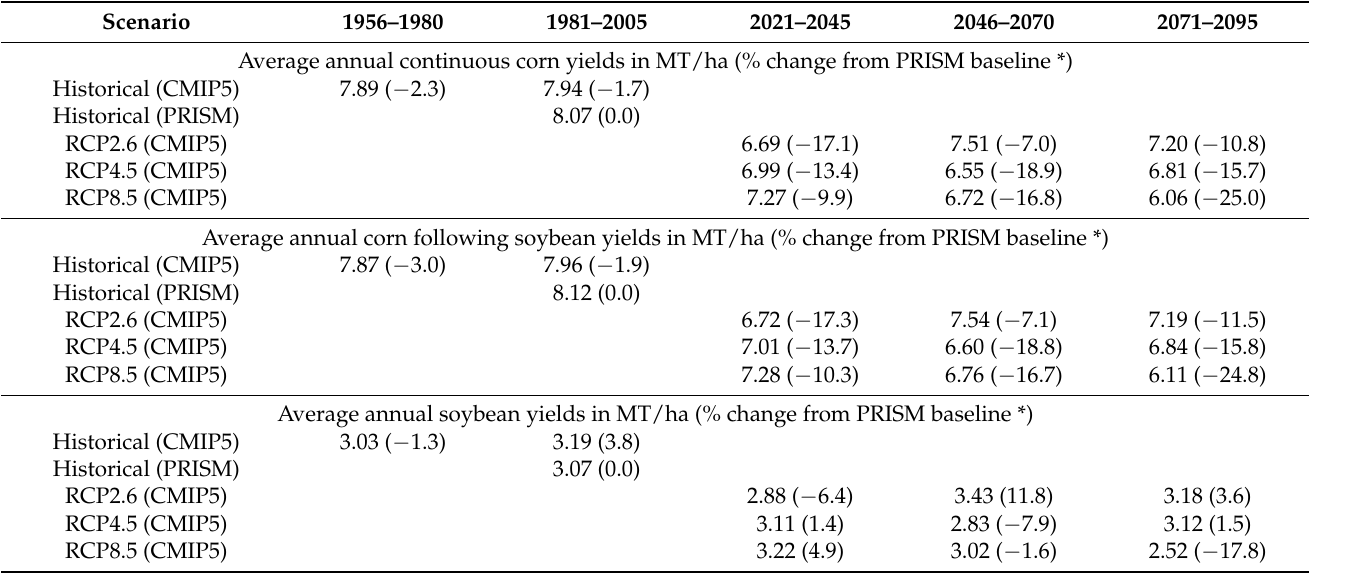
Table 8. Simulated impacts of climate scenarios on average annual corn and soybean yields based